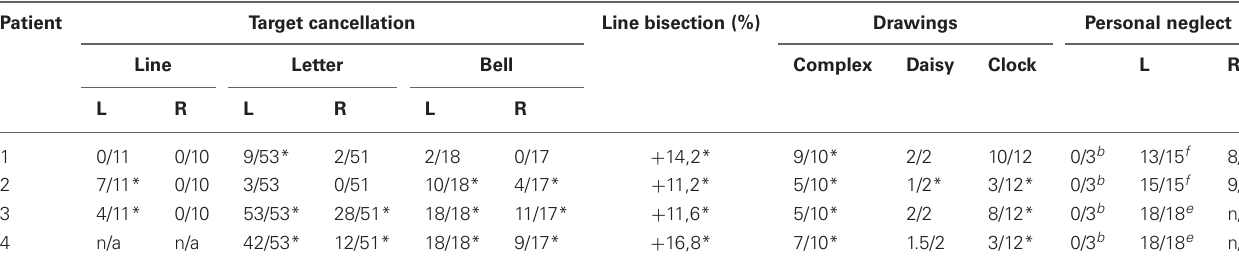
Table 2 | Neuropsychological assessment